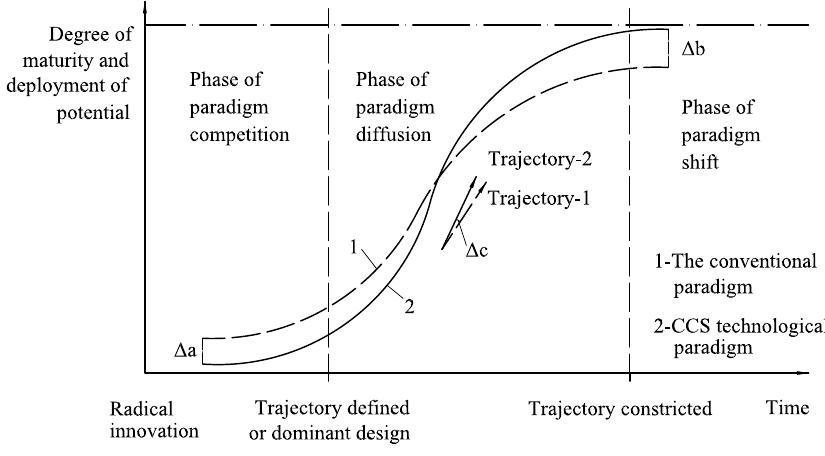
Figure 17. Development of CCS as a competitive abatement